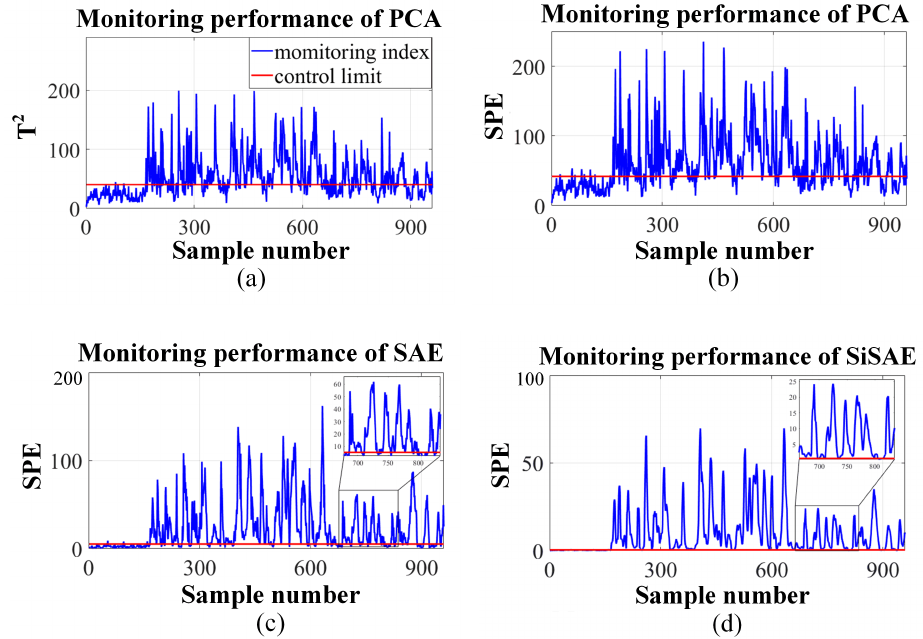
Figure 4. Monitoring results obtained with PCA, KPCA, SAE, and SiSAE for fault 11. ( a ) is the performance of T 2 of PCA, ( b – d ) is the performance of SPE of PCA, SAE, and SiSAE, respectively. Fault 19 was an unknown fault in the TE process that was difficult for most monitoring approaches to detect due to its similarity to normal conditions. Figure 5 depicts the moni- toring outcomes of PCA, SAE, and our approach for Fault 19. The detection performance indicates that it was difficult for the PCA, and SAE approaches to effectively detect the fault. However, our proposed method was able to detect nearly all fault samples of Fault